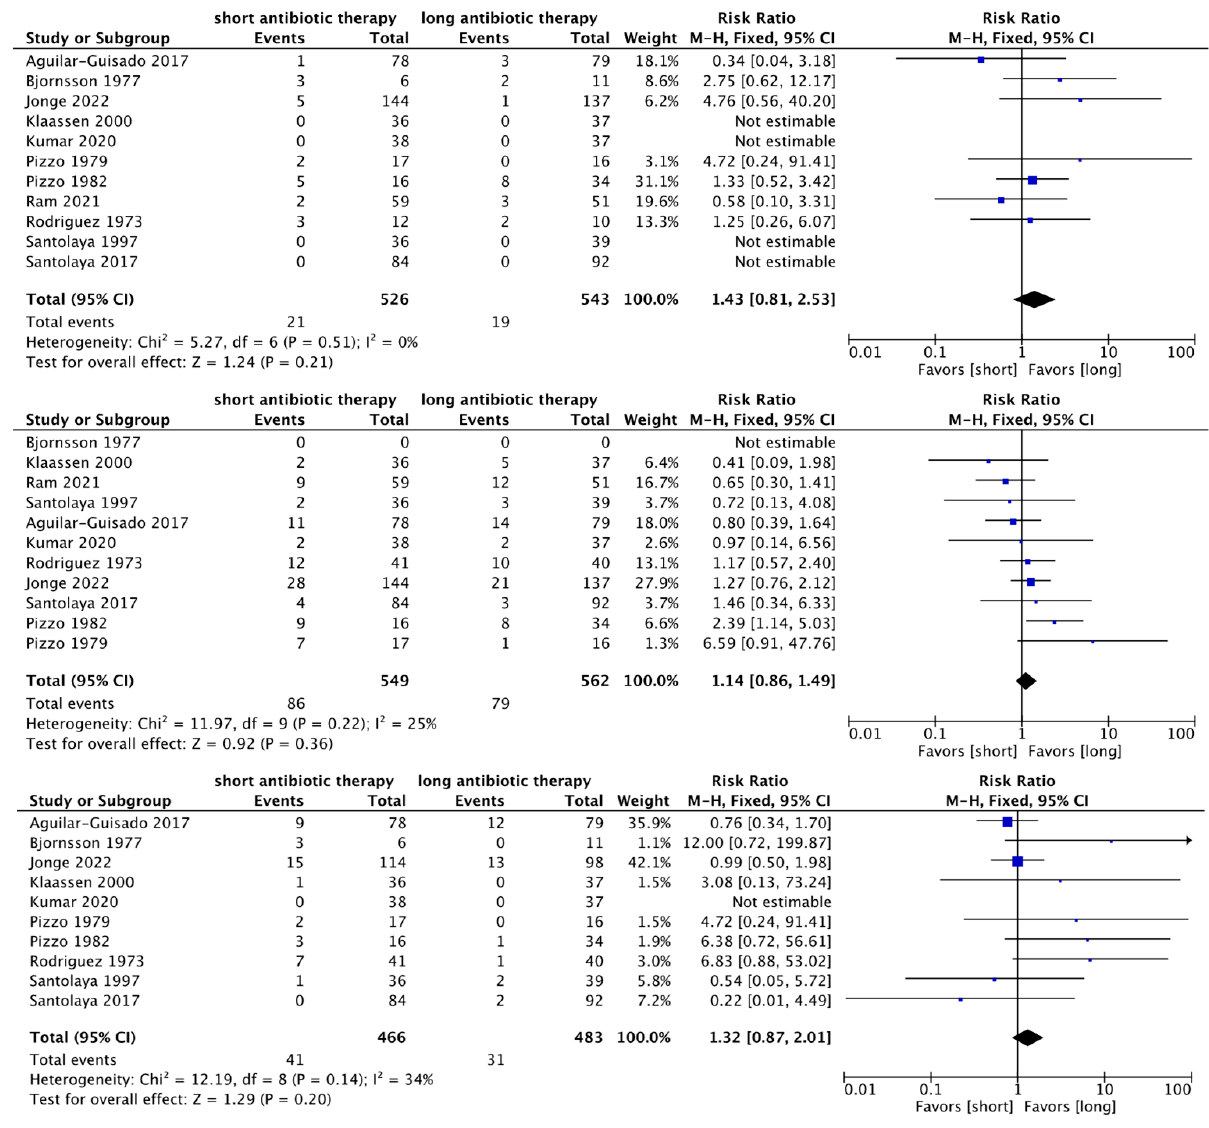
Figure 3. Summary of findings of short- compared with long-term duration antibiotic therapy presented as Forest plots, including the results reported by de Jonge et al. [12], Ram et al. [25], and Kumar et al. [22], and the results of the systematic review by Stern et al. [13]. Mortality ( above ), clinical failure ( middle ), and bacteremia ( below ). Total RR across 1 (left favors short, right favors long). Abbreviations: RCT, randomized control study, CI, confidence interval; RR, risk ratio [12,19– 28].